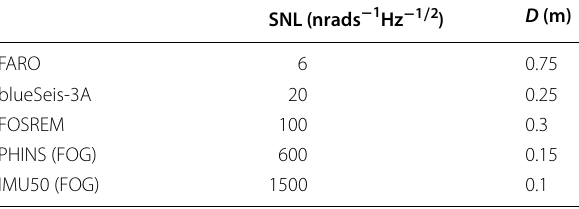
Table 1 Typical self-noise levels (SNL), and coil-diameters ( D ) of state-of-the-art fiber-optic